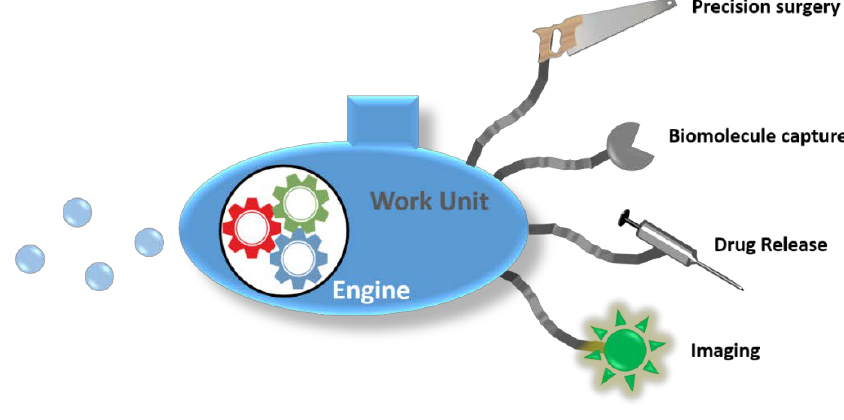
Figure 1. Principles of nanomotor for sensing: engine and sensors.